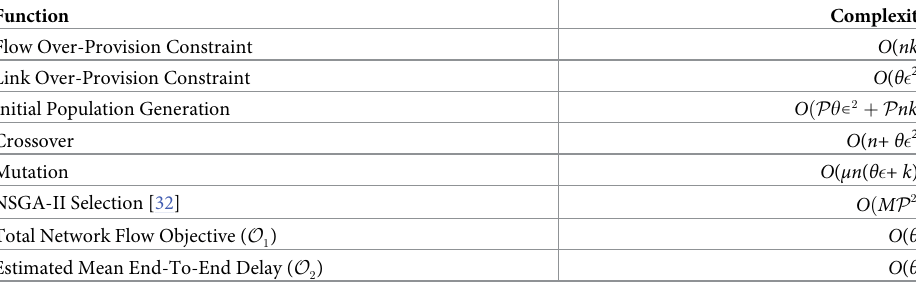
Table 2. Time complexity of each ERA